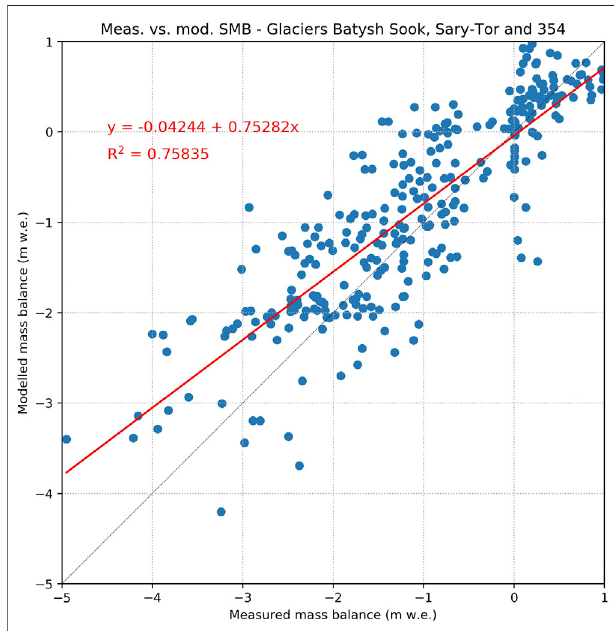
FIGURE 3 | Comparison of modelled and observed point measurements for the glaciers Sary-Tor, Batysh-Sook and Glacier 354.